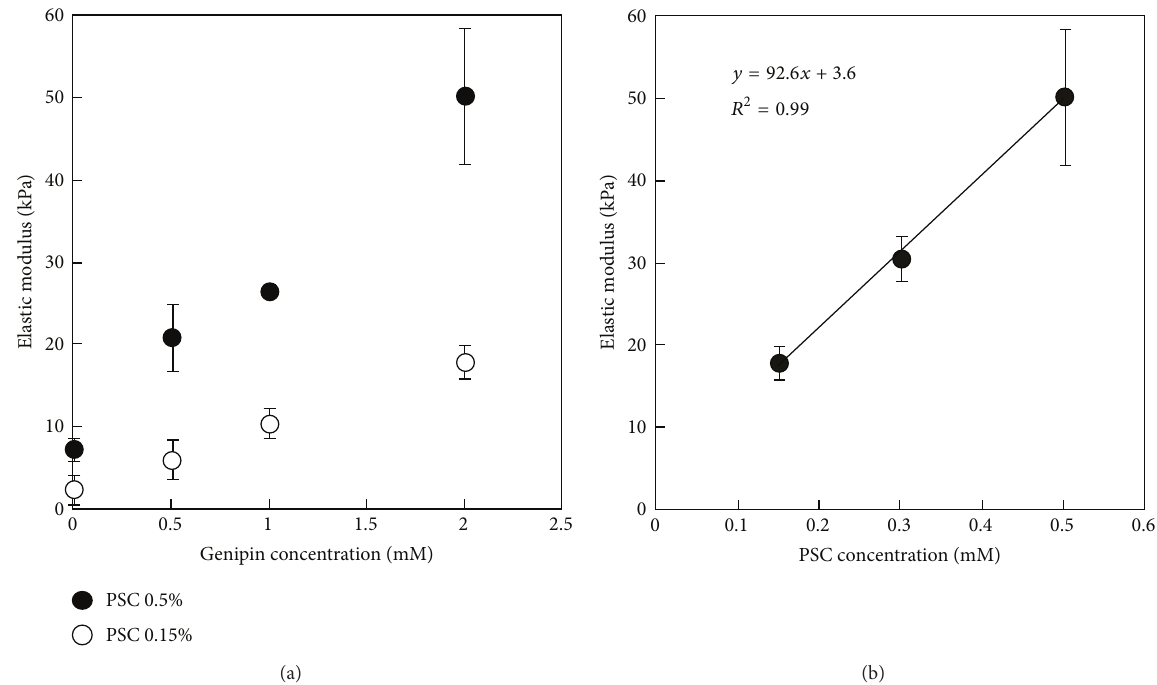
Figure 11: Elastic modulus of matured PSC/genipin gels obtained by a penetration test. (a) 0.5 and 0.15wt% PSC gels containing genipin at concentrations ranging from 0 to 4 mM. (b) 0.5, 0.3, and 0.15 wt% PSC gels containing 2mM genipin. The gels were matured by incubation for 72 h. Data are presented as mean ± SD; 𝑛 = 3